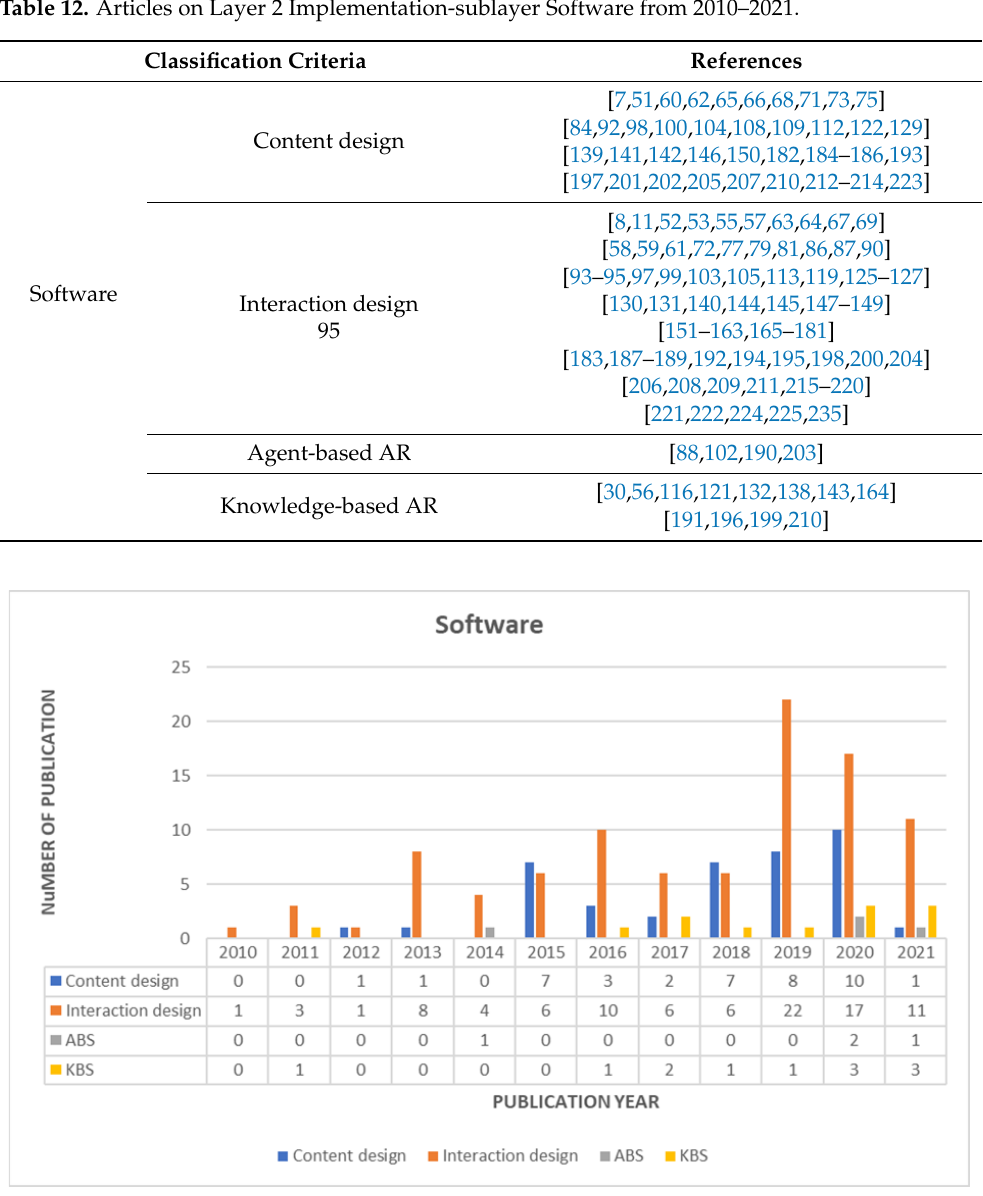
Figure 12. Number of articles about AR software design in manufacturing over years 2010 –